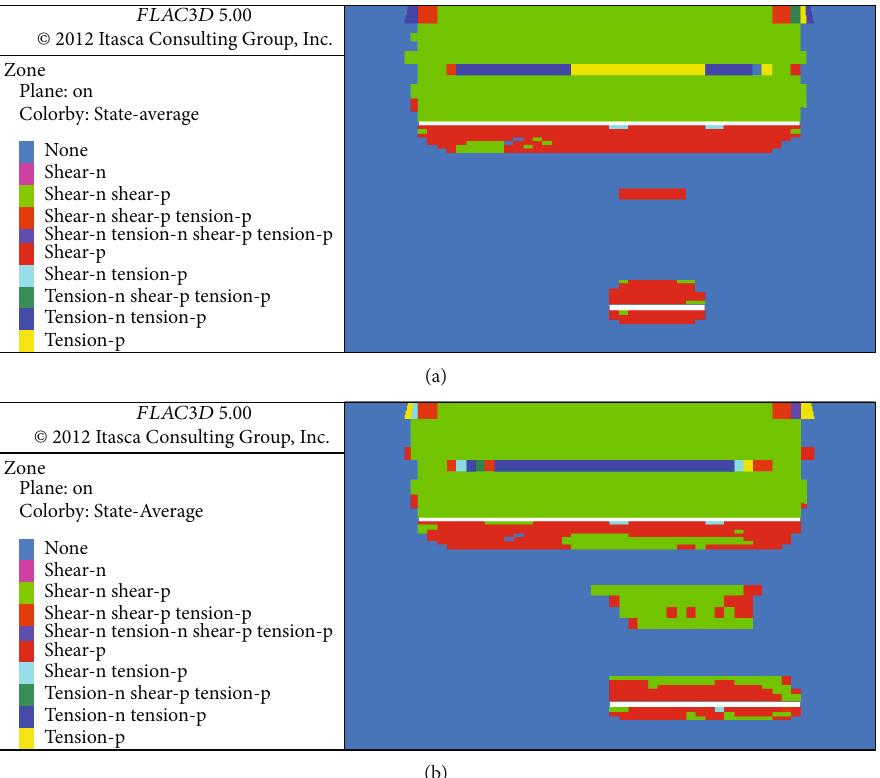
Figure 20: Cloud diagrams of the plastic zone changes in the propulsion of the J coal seam when the working face is pushed to (a) 100 m and (b)